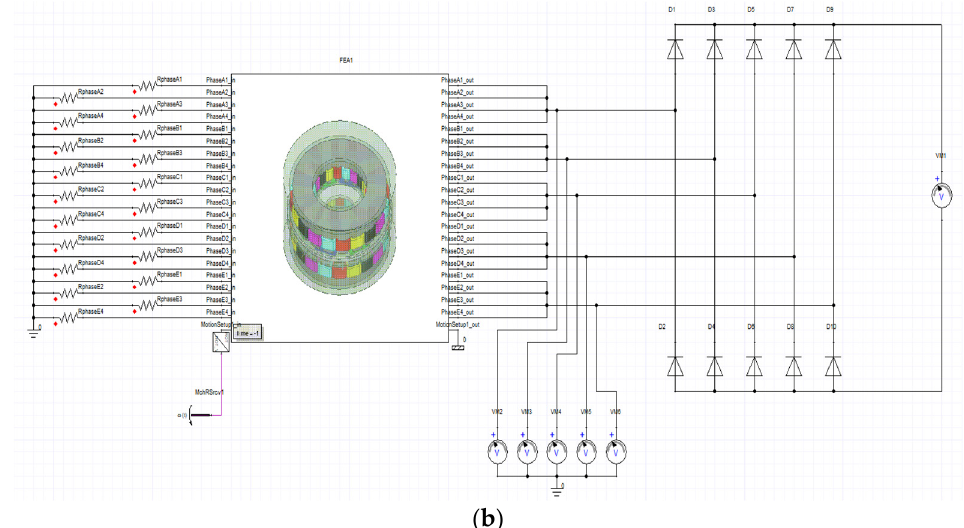
Figure 21. Schematic diagram of the co-simulation; ( a ) original generator, ( b ) proposed generator. The co-simulation is carried out under a no-load condition to compare the magnitude of the no-load rectified voltage and its ripple resulting from the two systems. The rectified voltage of the original and proposed generators is shown in Figure 22. Figure 22a shows the input voltage and rectified voltage of the three-phase full-wave rectifier. The input voltage and rectified voltage of the five-phase uncontrolled rectifier is shown in Figure 22b. To prove the correctness of the co-simulation, the average magnitude of the rectified voltage for the two systems is compared with the theoretical equation. The average rectified voltage of the three-phase system is calculated by 1.65 V m , and for the five-phase system this is calculated by 1.902 V m [28]. For the three-phase system, the measured magnitude is 50.17 V and the calculated magnitude is 48.09 V, and for the five-phase system, the measured magnitude is 72.88 V and the calculated magnitude is 75.45 V. The results show a slight deviation between the measured and calculated magnitudes for the two systems, which indicates that the co-simulation carried out for the two systems is correct. From Figure 22, it is shown that the rectified voltage of the five-phase system is smoother than the three-phase system. The calculated ripple of the three-phase rectifier is 32.34% and this is 3.63% for the five-phase rectifier. It shows that an improvement of 88.78% in the ripple of the rectified voltage is achieved by using the five-phase system, which reduces the size of the capacitor to smooth the rectified voltage.